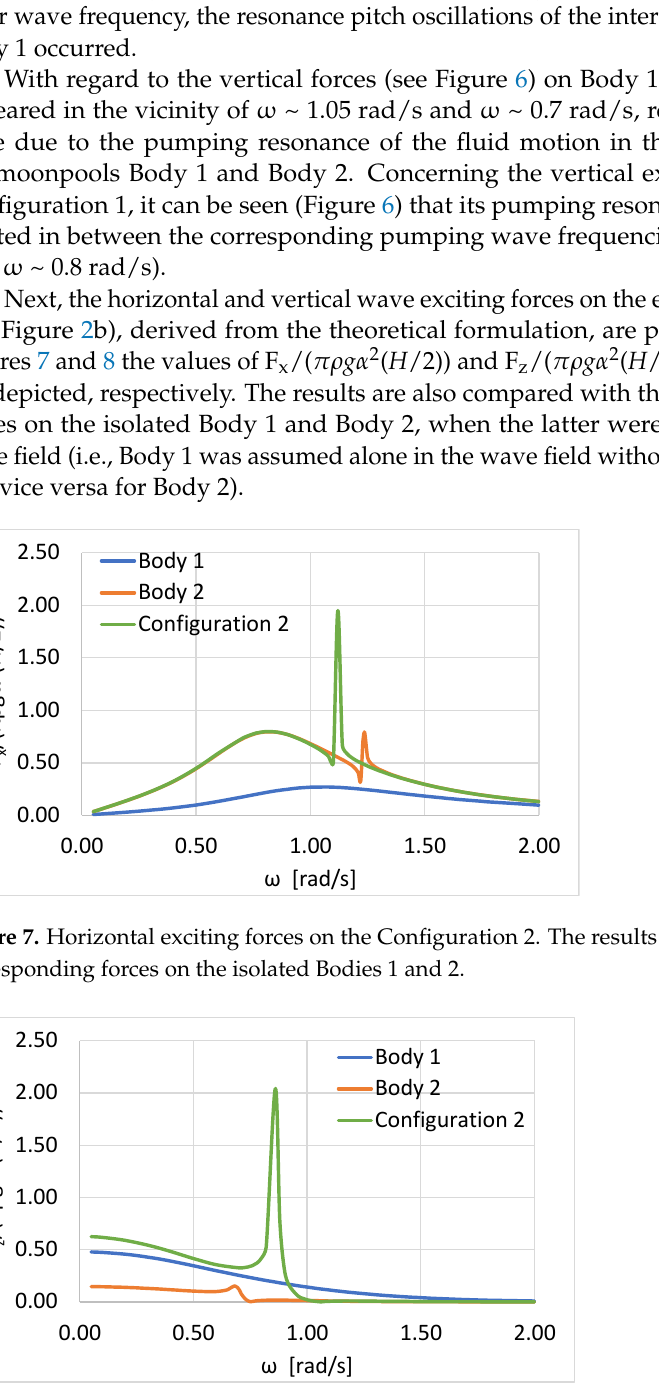
Figure 8. Vertical exciting forces on the Configuration 2. The results are also compared with the corresponding forces on the isolated Bodies 1 and 2 .